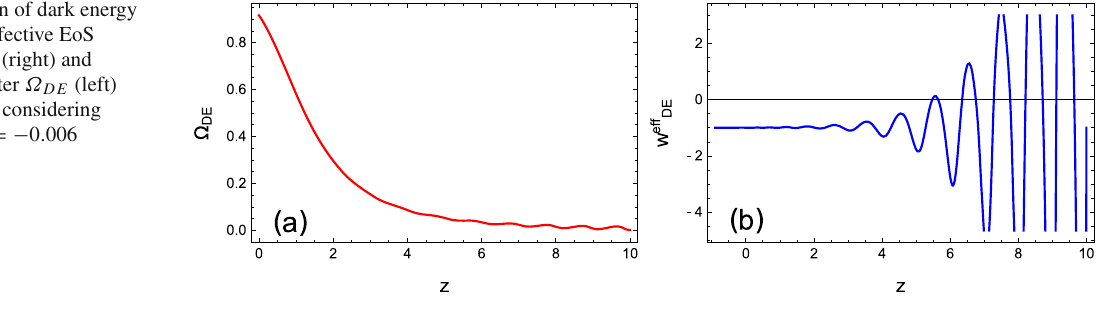
Table 3 Cosmological parameter values at the present epoch for Q < 0, with different η and α = 0 .